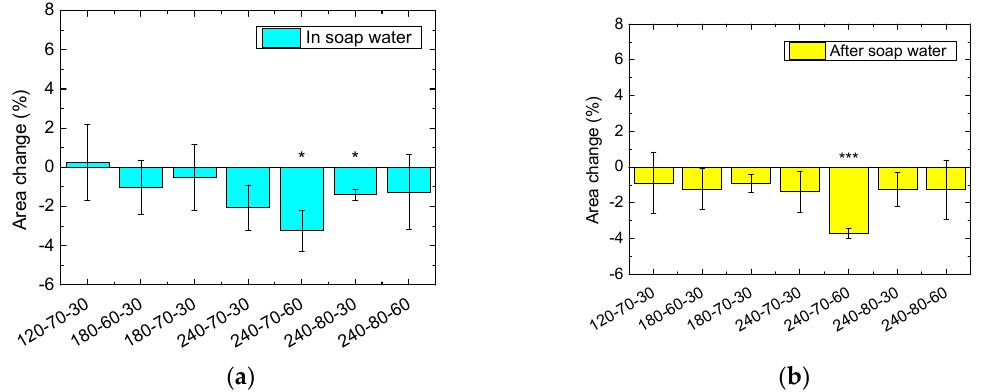
Figure 7. Percentage change of the areas of the electrospun PAN nanofiber mats ( a ) during exposition to water with soap; ( b ) after exposition to soap water and drying. Statistical significance is depicted by * ( p < 0.05), ** ( p < 0.01) or *** ( p < 0.002), respectively.